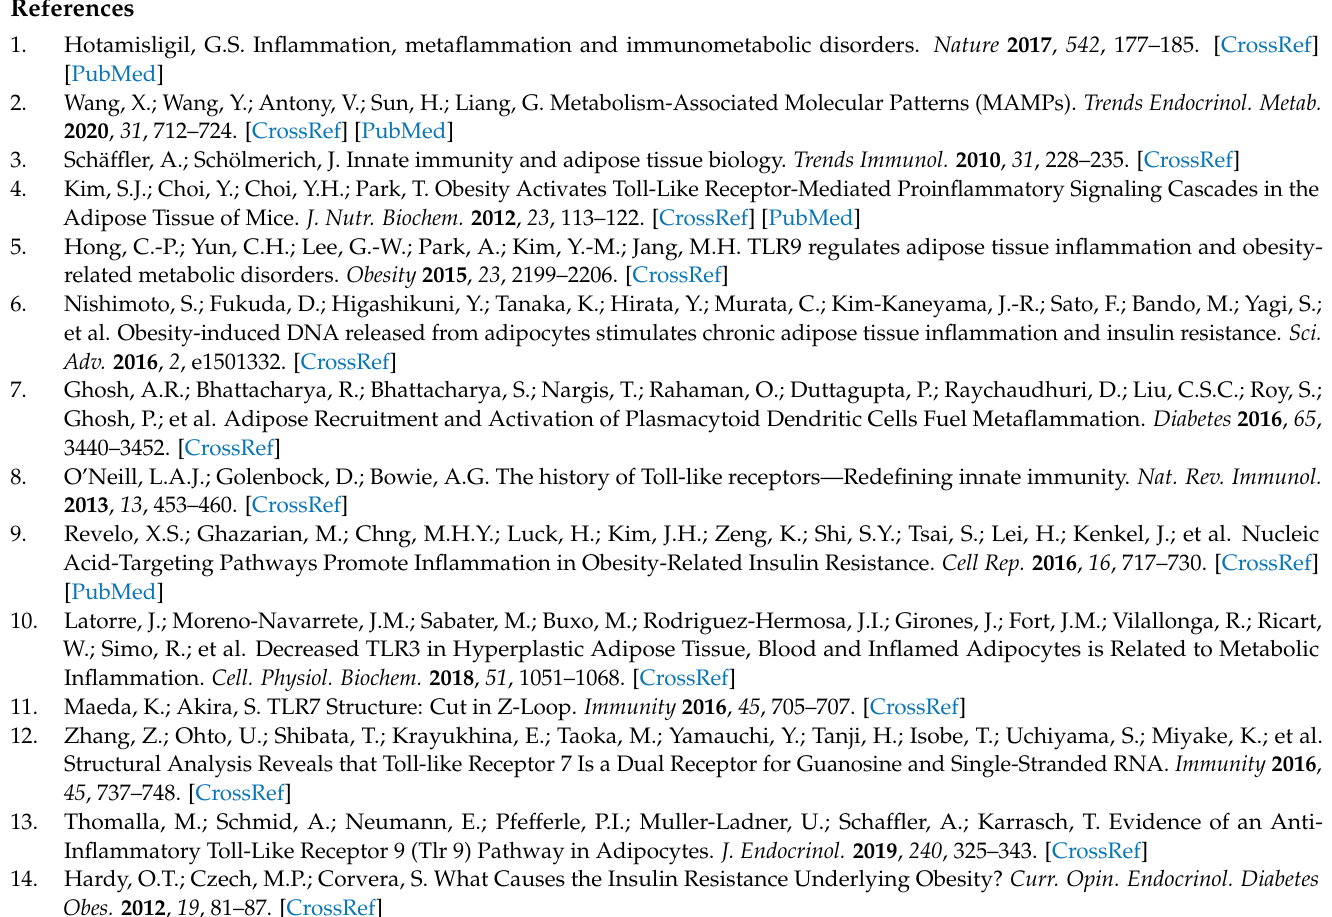
Table A2. Correlation analysis of TLR7 mRNA expression in visceral adipose tissue with clinical and anthropometric parameters and with systemic adipokine levels. n = 95 obese, non-diabetic patients (14 men, 81 women). Correlation analysis was done by using the Spearman-rho test, and the respective Spearman rho and p -values are given. The bold in the table marks statistically significant correlations. TLR7 mRNA (subcutaneous